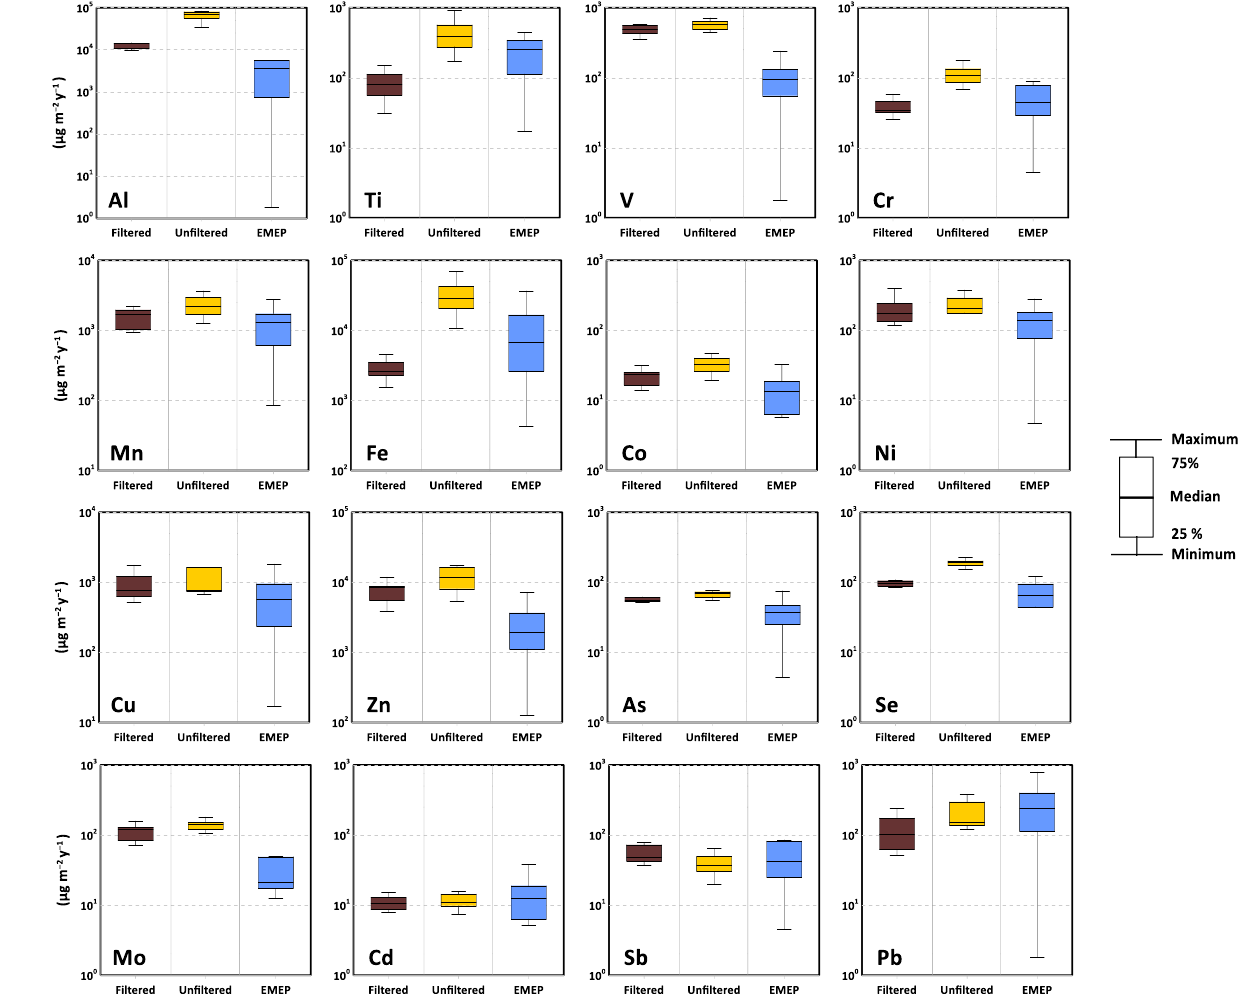
Figure 9. Comparison between some selected trace element deposition fluxes measured in atmos- pheric deposition samples from Sicily and Europe.